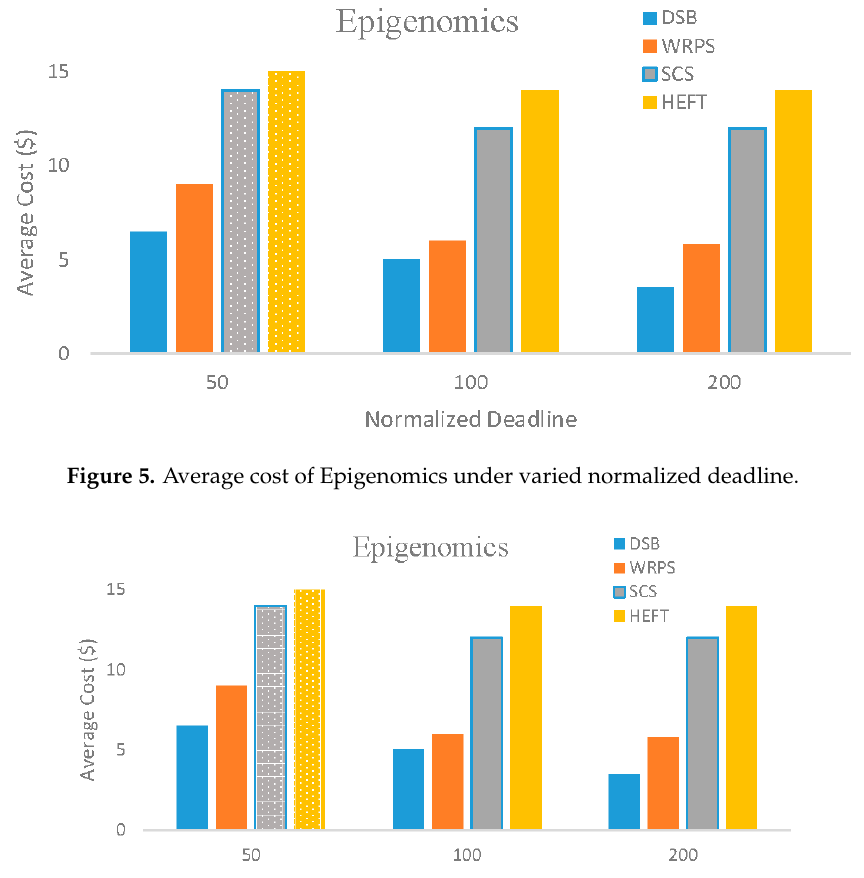
Figure 3. Average cost of Montage under varied normalized deadlines.